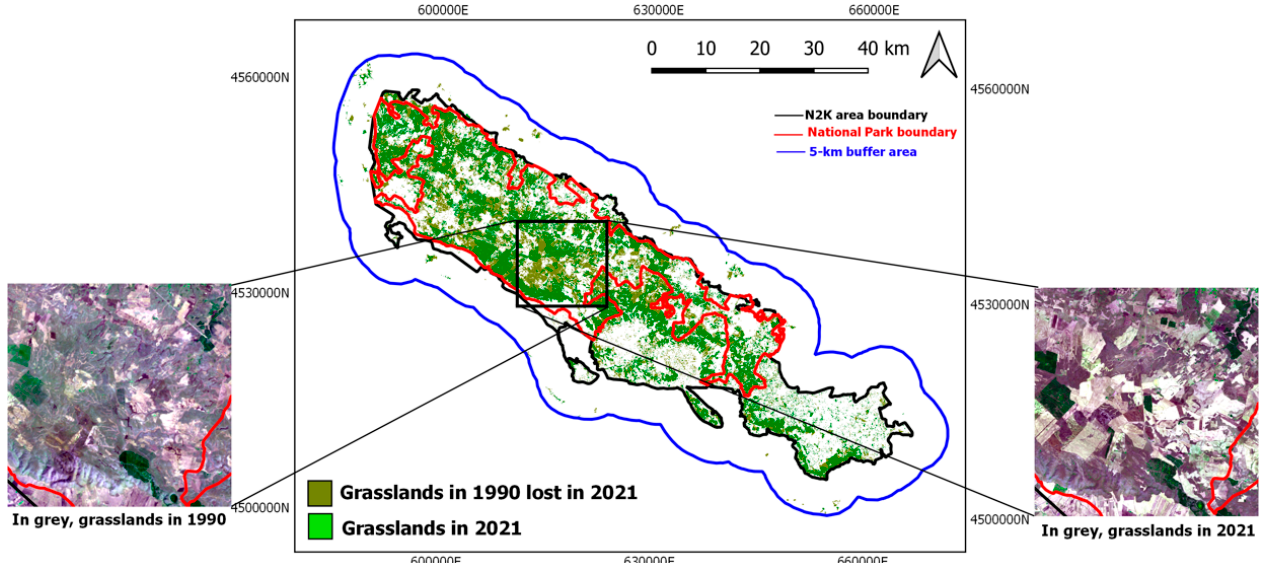
Figure 15. Grasslands mapping for 2021 overlapped over that for 1990: grasslands lost in 2021 results in mustard yellow. Two close-ups on the sides show the satellite images (in RGB composition: Red- NIR-Blue) for 1990 (Landsat) and 2021 (Sentinel-2) on the left and right side, respectively: the loss of grasslands in the square area to cultivated area can be appreciated.